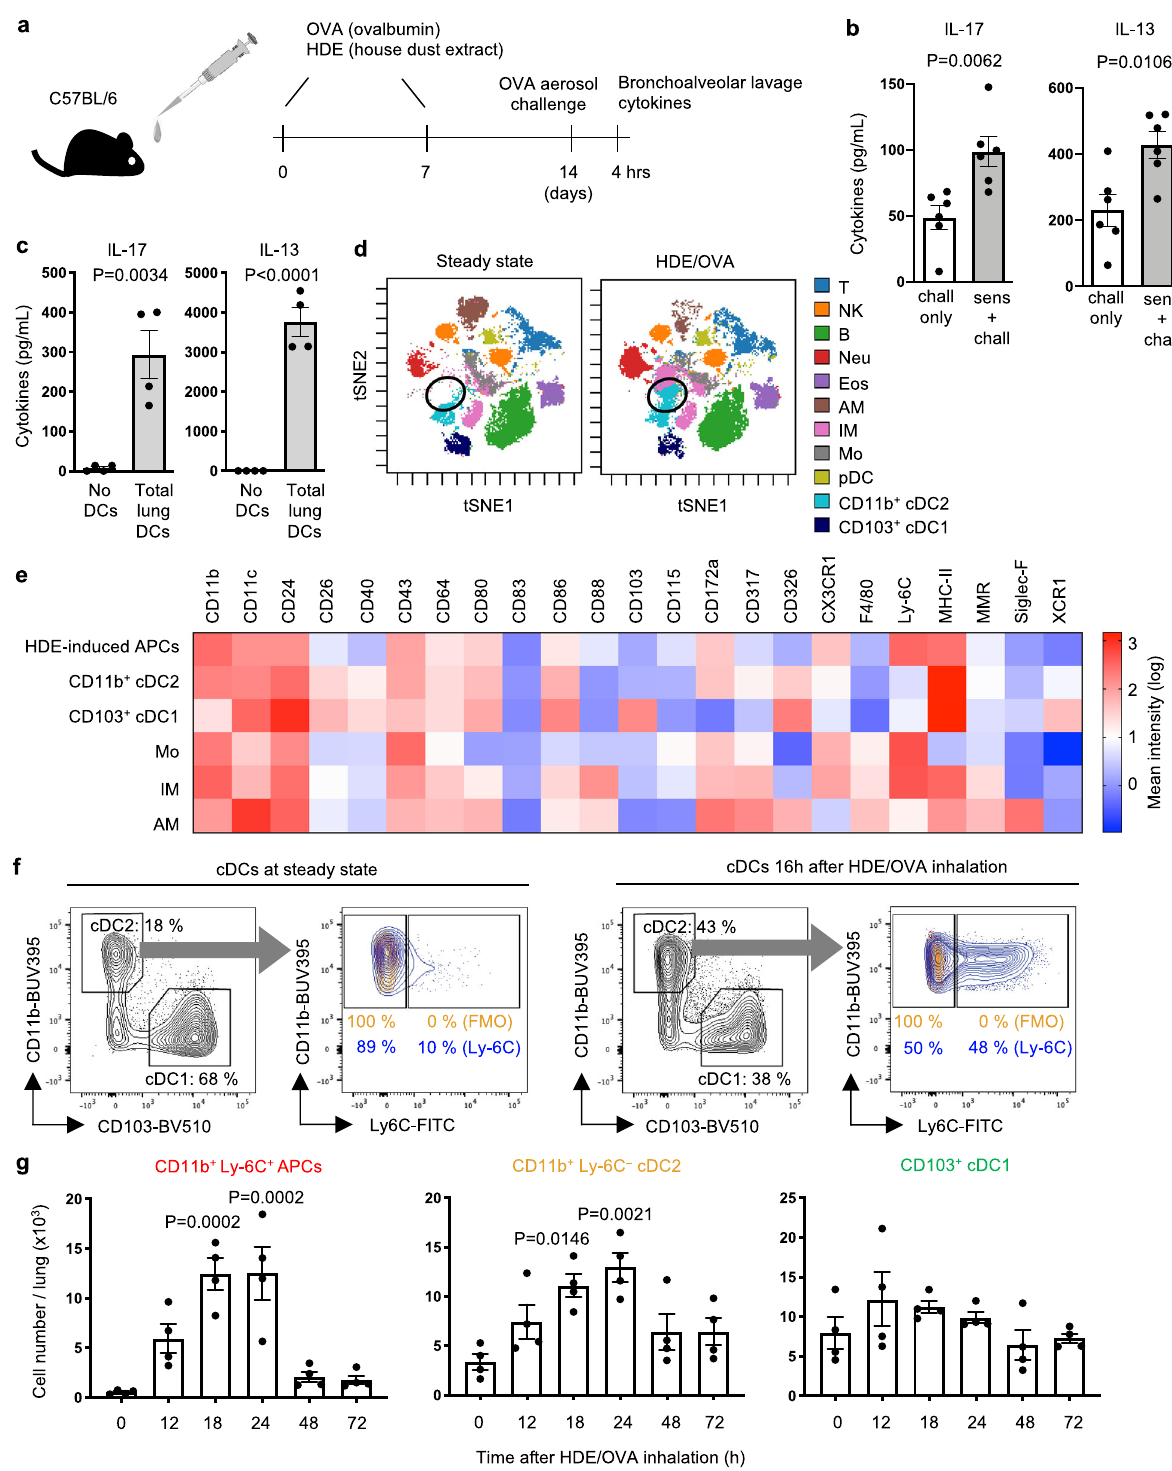
APCs and in Ly-6C – cDC2 and cDC1, but not in monocytes (Fig. 2d and Supplementary Fig. 4b). Conversely, expression of macrophage-signature genes 36,37 was lower in Ly-6C + HDE- induced APCs than in monocytes (Supplementary Fig.